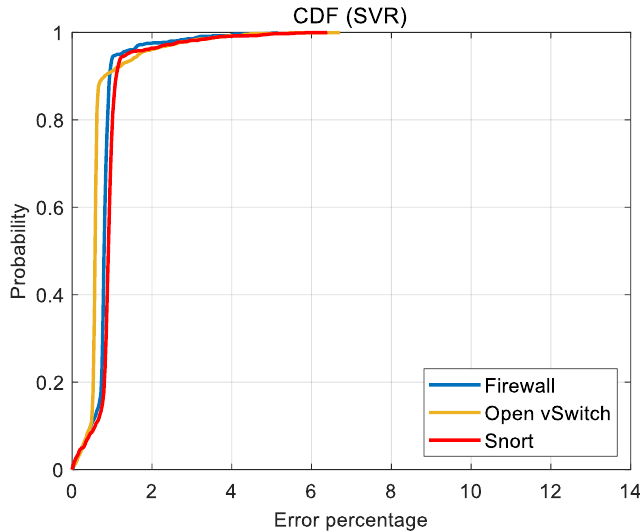
Figure 11. CDF of percentage prediction errors of SVR.